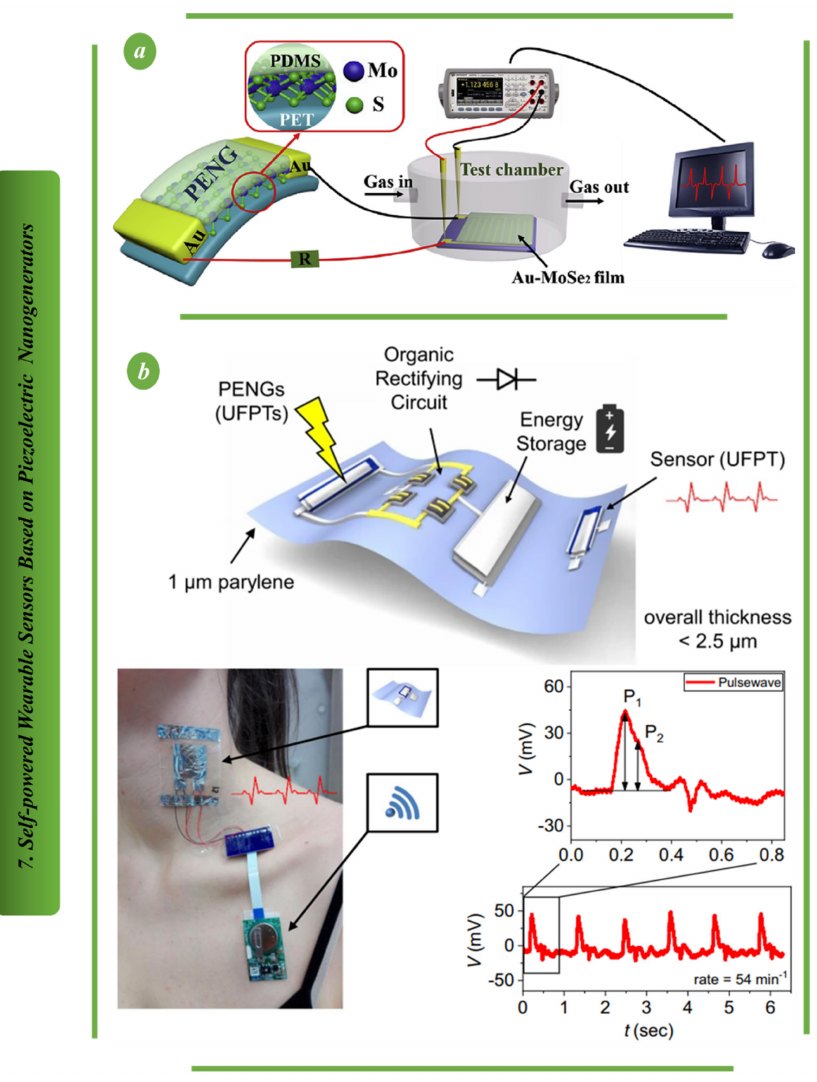
Figure 7. Self − powered wearable sensors based on PENG: ( a ) The design principal of self − power sensor based on flexible piezoelectric nanogenerator [93]. ( b ) Structure of biomedical sensor based on ultraflexible piezoelectric energy harvesting and sensing device